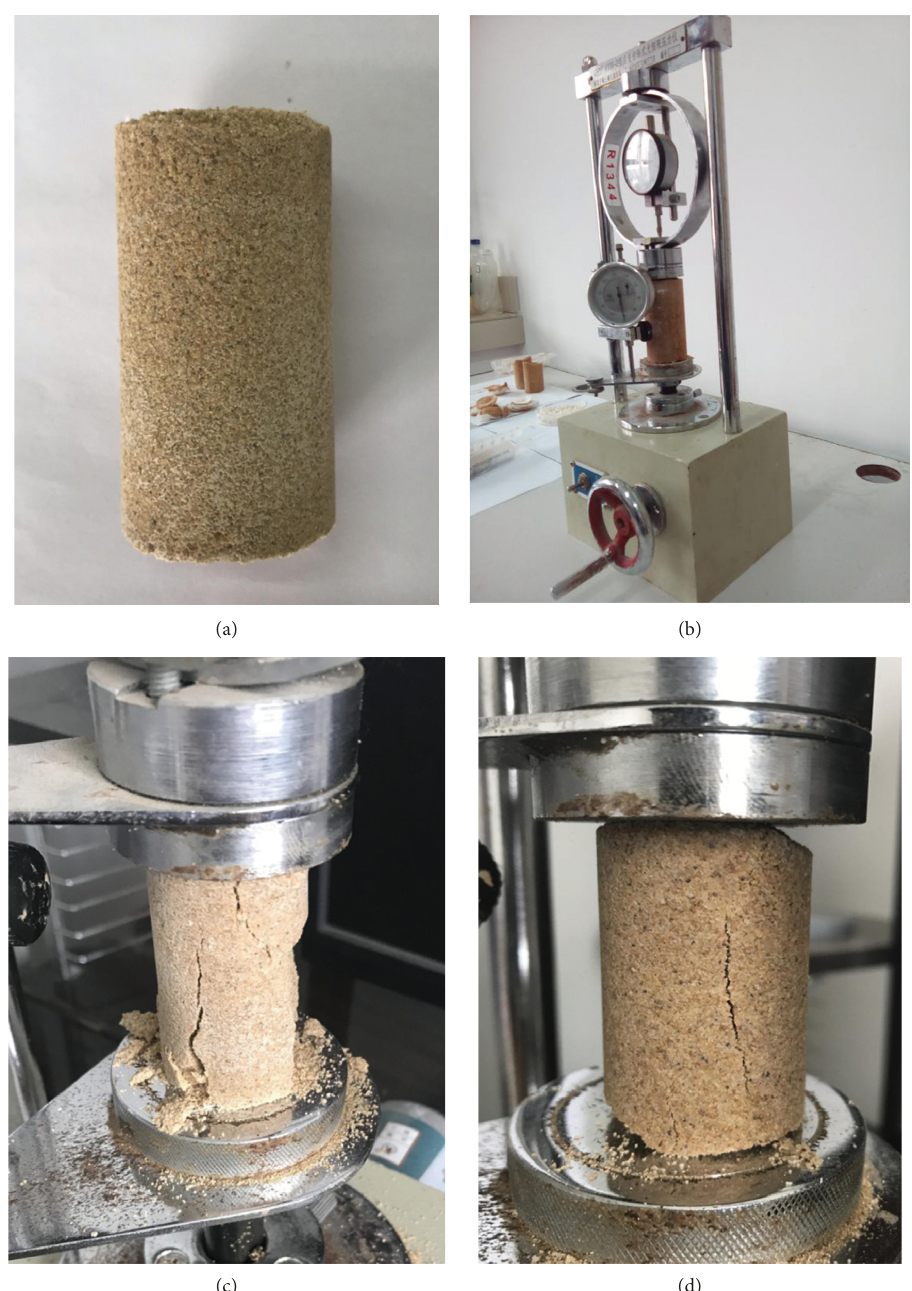
Figure 4: Photo of unconfined compression (UCC) strength tests: (a) MICP-treated sand specimen; (b) test setup; (c) specimen no. 3 at failure; (d) specimen no. 4 at